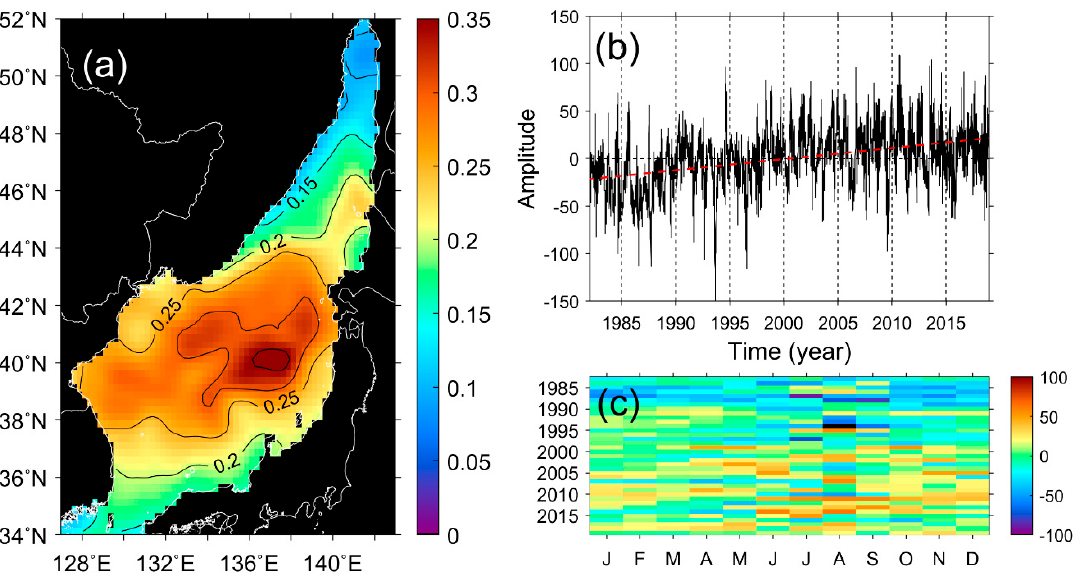
Figure 3. ( a ) Spatial distribution of eigenvectors from the first EOF mode using OISST anomaly data, for the observation period from 1982 to 2018, for the EJS; ( b ) temporal variability of the amplitude of ( a ), where the red dashed line is a least squares linear fit ( y = 1.17x − 2340.80 ); and ( c ) month-year plot of ( b ).